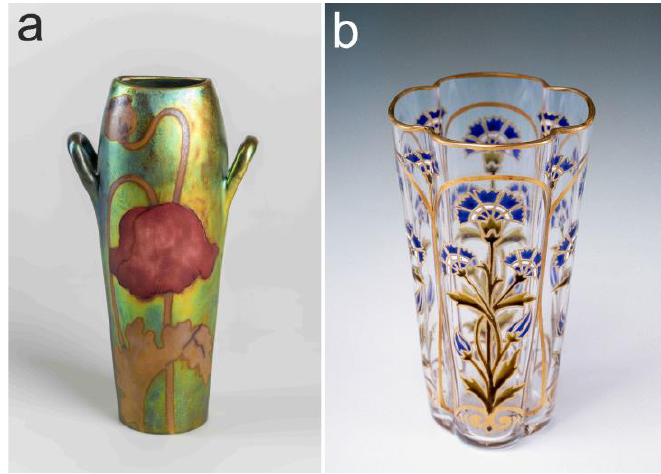
Figure 11. Ceramics from the Hungarian Art Nouveau: ( a ) Vase with red poppies (ca. 1900, Zsolnay factory, Museum of Applied Arts, Budapest. Photograph by Jonatán Urbán and Dávid Kovács. © Iparművészeti Múzeum); ( b ) Cup with cornflowers (1896, Henrik Giergl company, Museum of Applied Arts, Budapest. Photograph by Á gnes Kolozs. © Iparművészeti Múzeum).